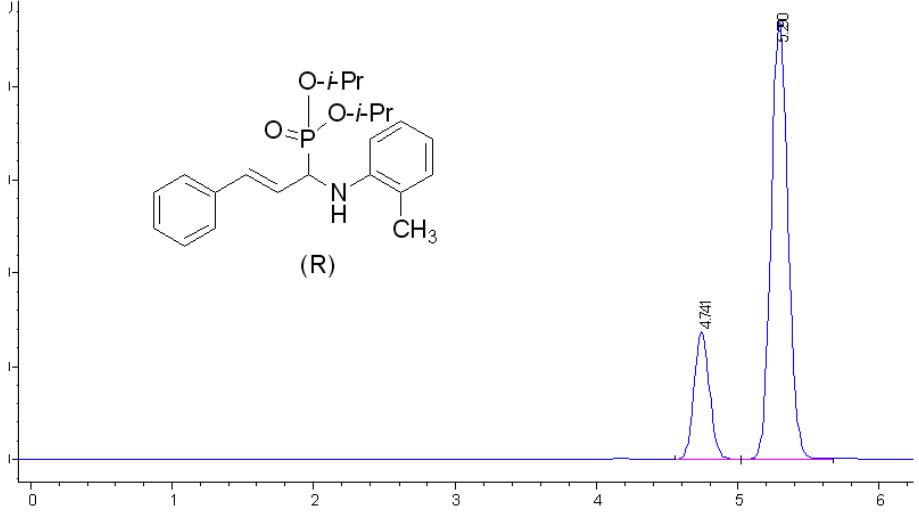
Figure 1. Representative chiral HPLC chromatogram of enantioenriched α -aminophosphonate 9k